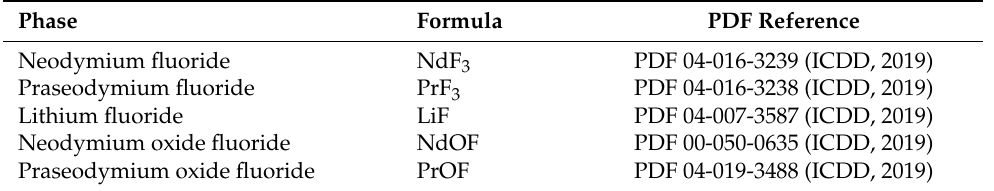
Table 2. Powder Diffraction File (PDF) references used for the XRD analysis. Phase Formula PDF Reference Neodymium fluoride NdF 3 PDF 04-016-3239 (ICDD, 2019) Praseodymium fluoride PrF 3 PDF 04-016-3238 (ICDD, 2019) Lithium fluoride LiF Neodymium oxide fluoride NdOF PDF 00-050-0635 (ICDD, 2019) Praseodymium oxide fluoride PrOF PDF 04-019-3488 (ICDD, 2019) The concentration of the electrolyte was kept at 50 mol% REF and 50 mol% LiF for